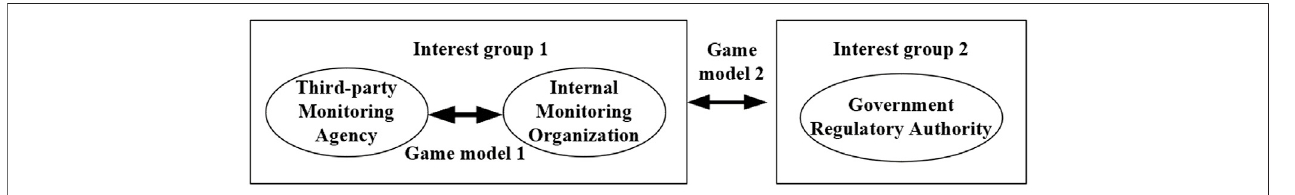
FIGURE 1 | Game relationship between the three stakeholders.